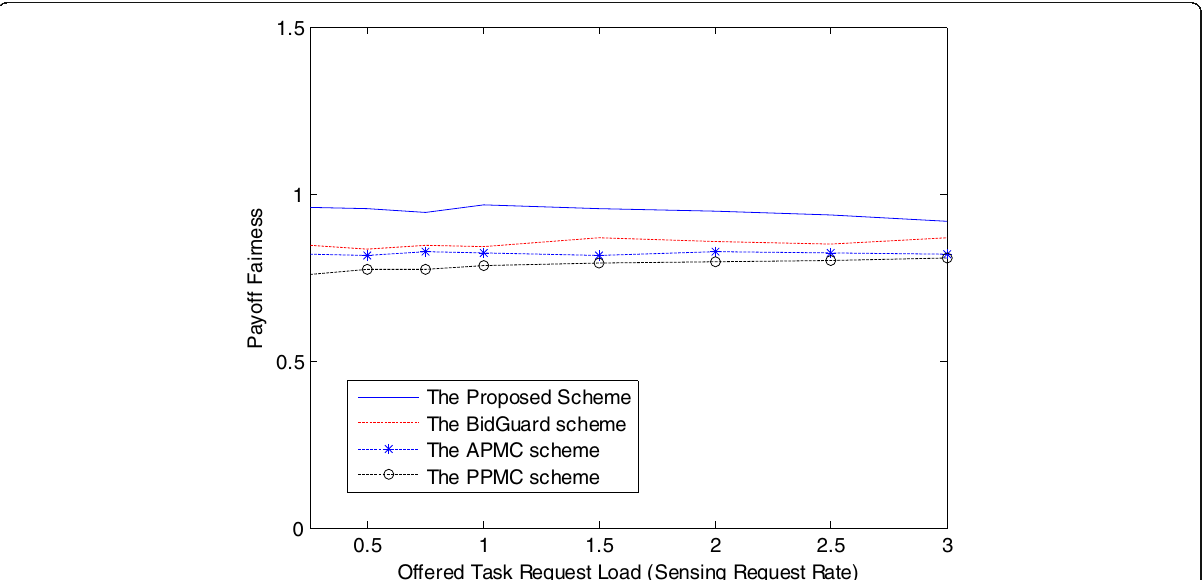
Fig. 3 MUD payoff fairness. To characterize this fairness notion, the Jain ’ s fairness index is adopted; it has been frequently used to measure the fairness of network management